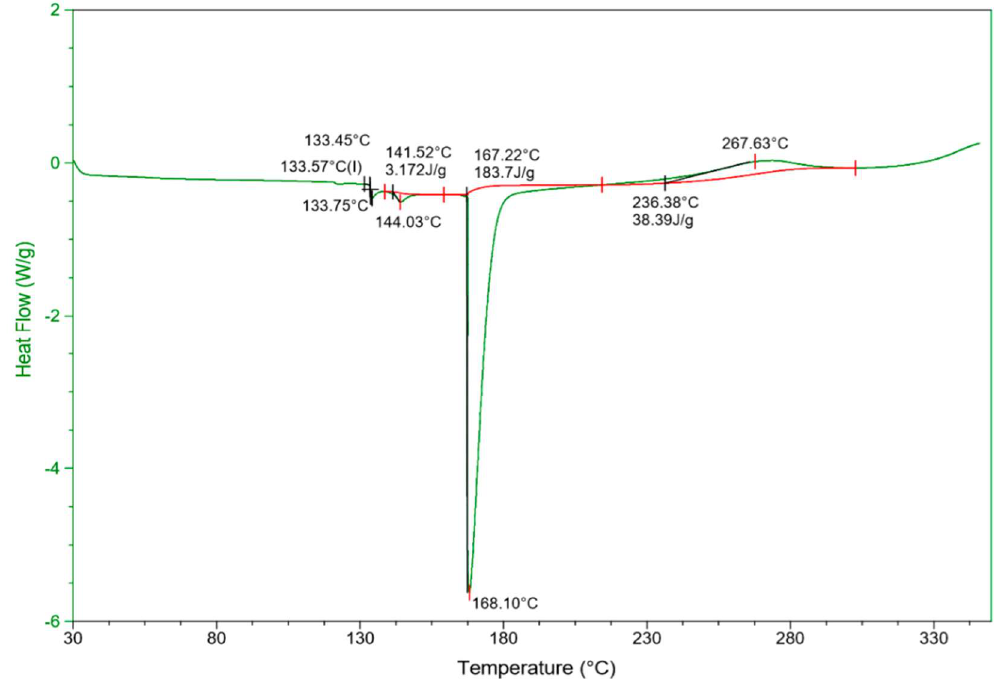
Figure 7. Di ff erential scanning calorimetry (DSC) result on the performance of composites, considering Figure 7. Differential scanning calorimetry (DSC) result on the performance of composites, heat flow versus considering heat flow versus temperature.